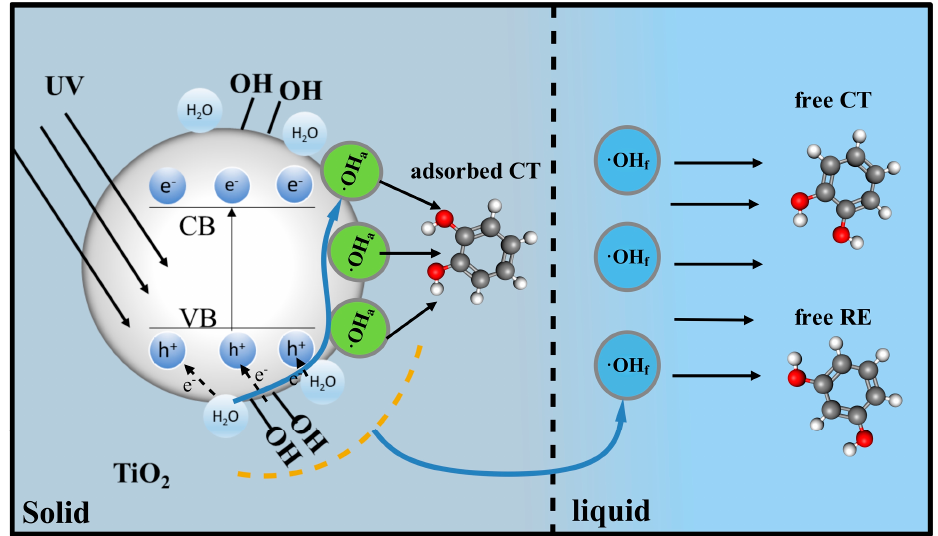
Figure 7. Schematic graph of the selective catalytic degradation of CT and RE by ∙ OH a and ∙ OH f .